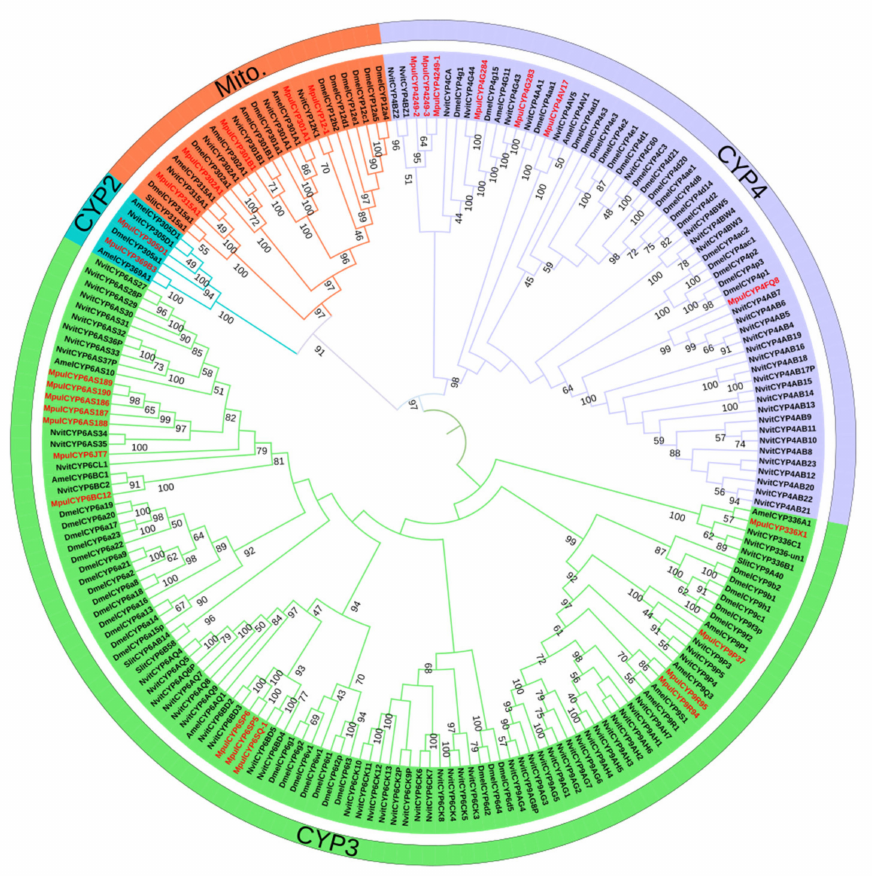
Figure 2. Phylogenetic analysis of P450s. Meteorus pulchricornis (Mpul), Spodoptera litura (Slit), Apis mellifera (Amel), Drosophila melanogaster (Dmel), Nasonia vitripennis (Nvit). Different colors indicate CYPs in different